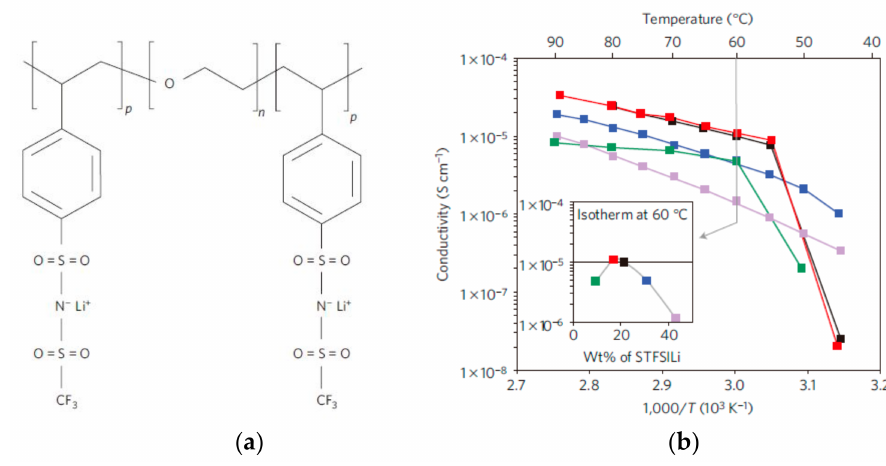
Figure 7. ( a ) Chemical structure of the single-ion conductor triblockcopolymer P(STFSILi)–b–PEO–b–P(STFSILi); ( b ) Conductivity performances. Plots of conductivity as a function of inverse temperature for P(STFSILi)–PEO–P(STFSILi)